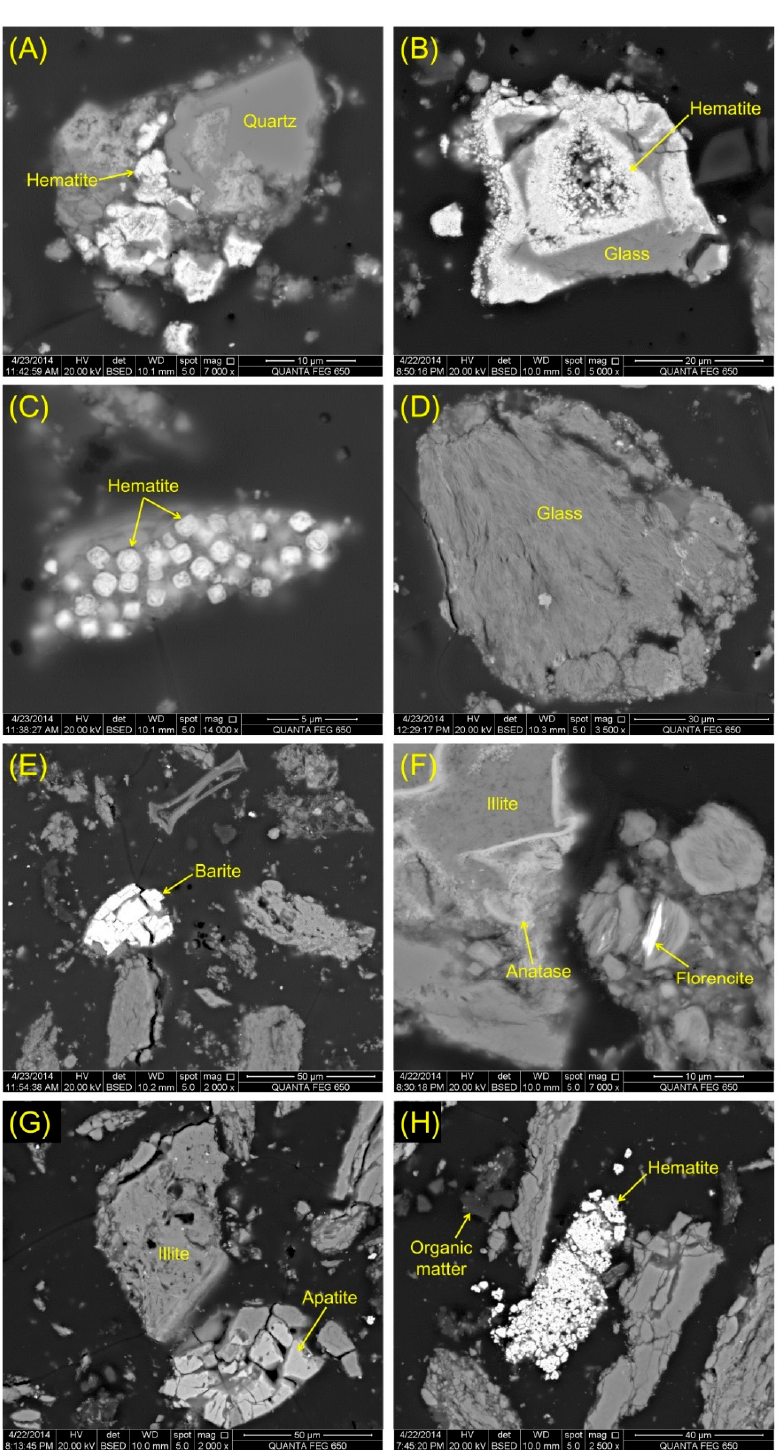
Figure 7. SEM backscattered images of minerals in the combustion products from the Xilaifeng and Damo power plants. ( A ) quartz; x-fa2-10; ( B ) hematite; d-fa(f)-6; ( C ) hematite; x-fa2-10; ( D ) glass; x-fa1-11; ( E ) barite; x-fa2-10; ( F ) florencite and anatase; d-fa(f)-6; ( G ) apatite; d-fa(f)-6; ( H ) organic matter and hematite; d-fa(f)-6.